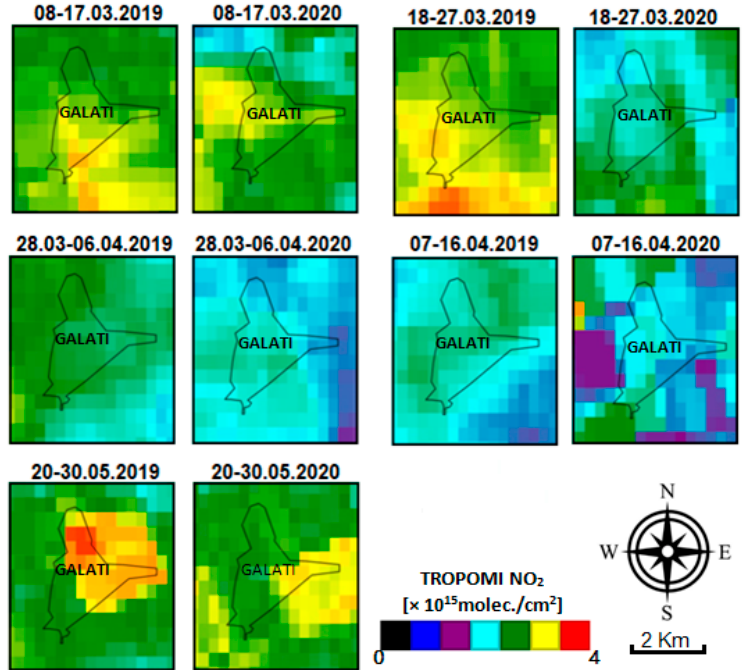
Figure 4. The average NO 2 VCD over 10 days measured by TROPOMI before (8–17 March), during (18 May–16 April), and after (20–30 May) the COVID-19 lockdown. These are compared with results from the same time intervals in 2019.